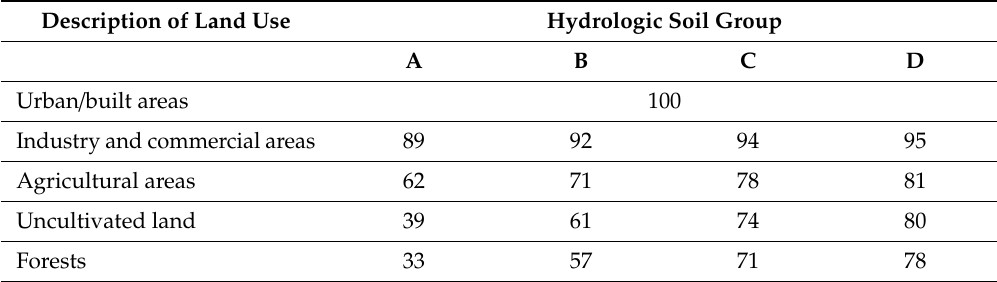
Table 4. Curve Number (CN) from soil type data (1992) and soil occupation (2007) in Funchal. Tabulated